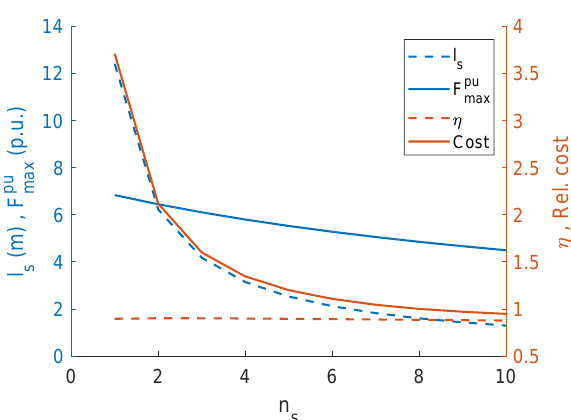
Figure 5. Stator length, maximum damping force in per unit, efficiency and relative cost for the original generator design with varied number of conductors per slot, n s and an adjusted stator length, l s to achieve an output power of 18.4 kW.